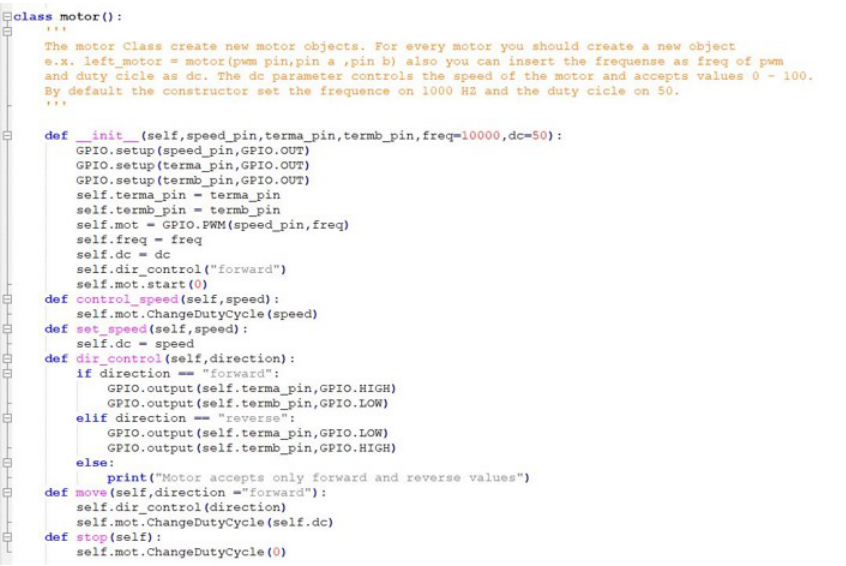
Figure 7. Real coding mode